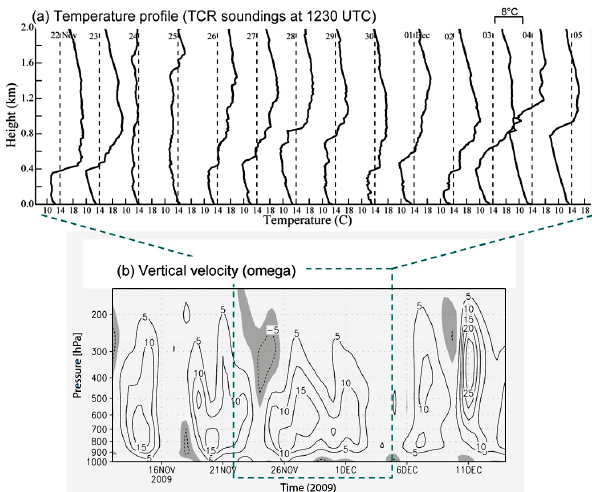
Fig. 10. (a) Vertical profiles of air temperature from the 12:30UTC (morning) soundings at Talcaruca for each day during CUpEx (dates at the top). The horizontal (temperature) scale is identi- cal for each sounding and the vertical dashed line is the refer- ence 14 ◦ C isotherm. (b) Vertical velocity ( ω · 100, contoured ev- ery 0.05hPas − 1 , shaded area indicates ascending motion) at 30 ◦ S, 73 ◦ W during November–December 2009. The CUpEx period is indicated by the green box. Data source: NCEP-NCAR reanalysis.